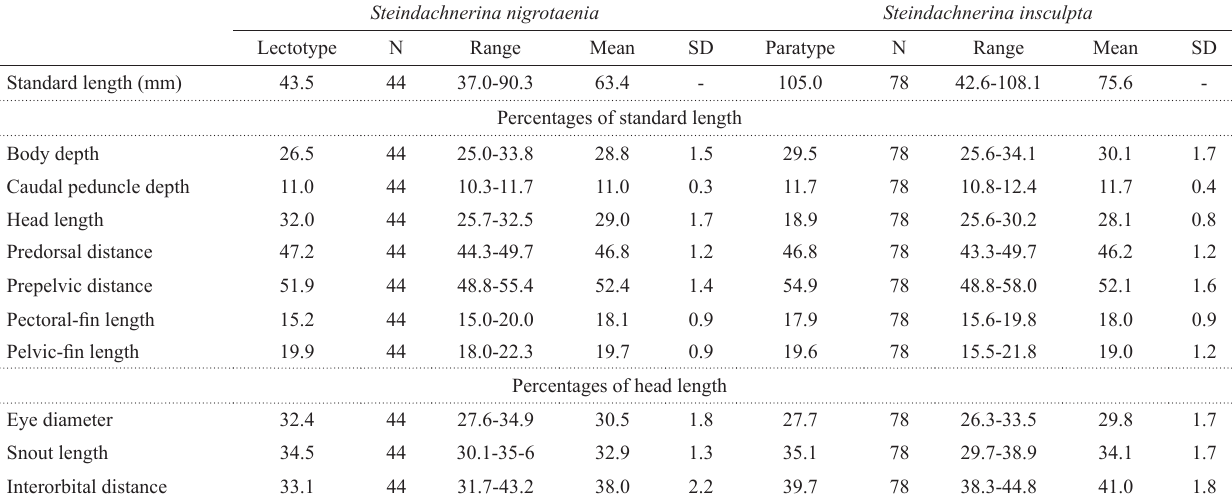
Tab. 2. Morphometric data for Steindachnerina nigrotaenia and S. insculpta . N = number of specimens. SD = Standard deviation. Range of each species includes the lectotype of S. nigrotaenia (BMNH 1902.2.10.30) and the paratype of S. insculpta (MZUSP 1376),